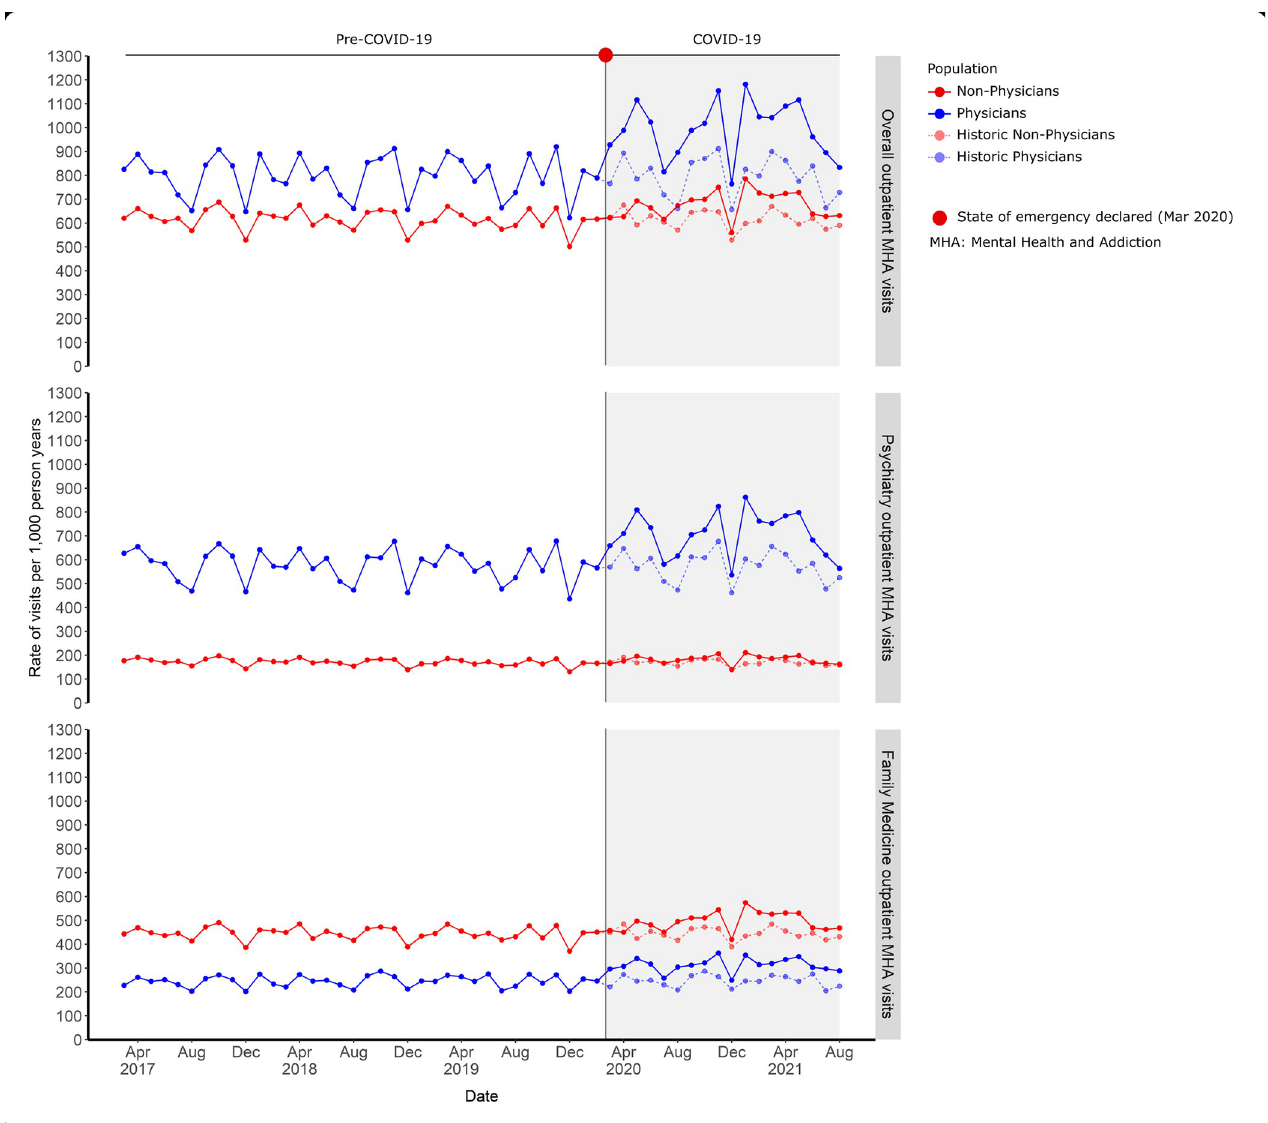
Fig 1. AU : AbbreviationlistshavebeencompiledforthoseusedinFigs 1 and 2 andTables 2 and 3 : Pleaseverifythatallentriesarecorrect : Age and sex standardized monthly rates of outpatient MHA visits overall, to psychiatrists, and to family physicians among physicians and non– physicians. Historic rates depict rates from March 2018 to August 2019. COVID–19, Coronavirus Disease 2019; MHA, mental health and addiction.